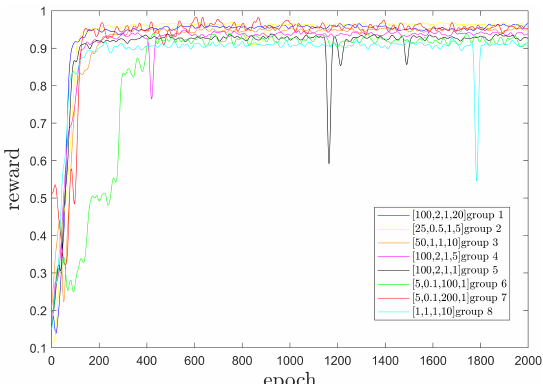
Figure 5. Average reward per epoch.